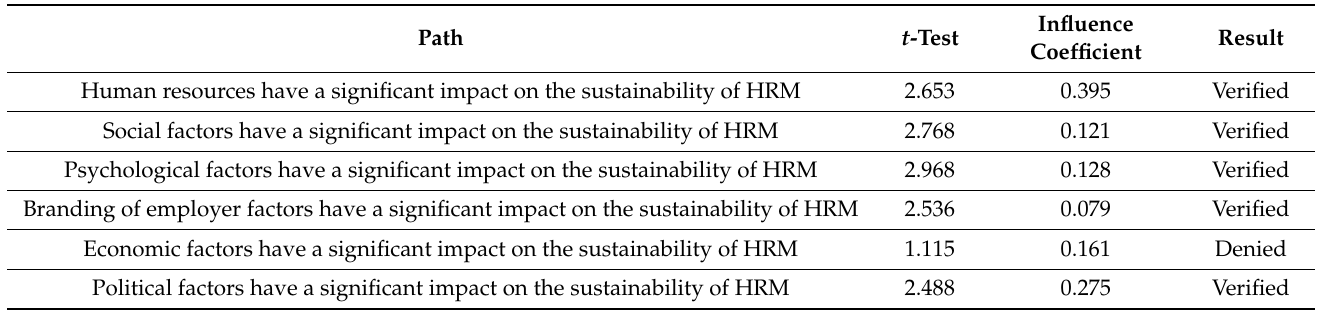
Table 4. Path relationships (Source: